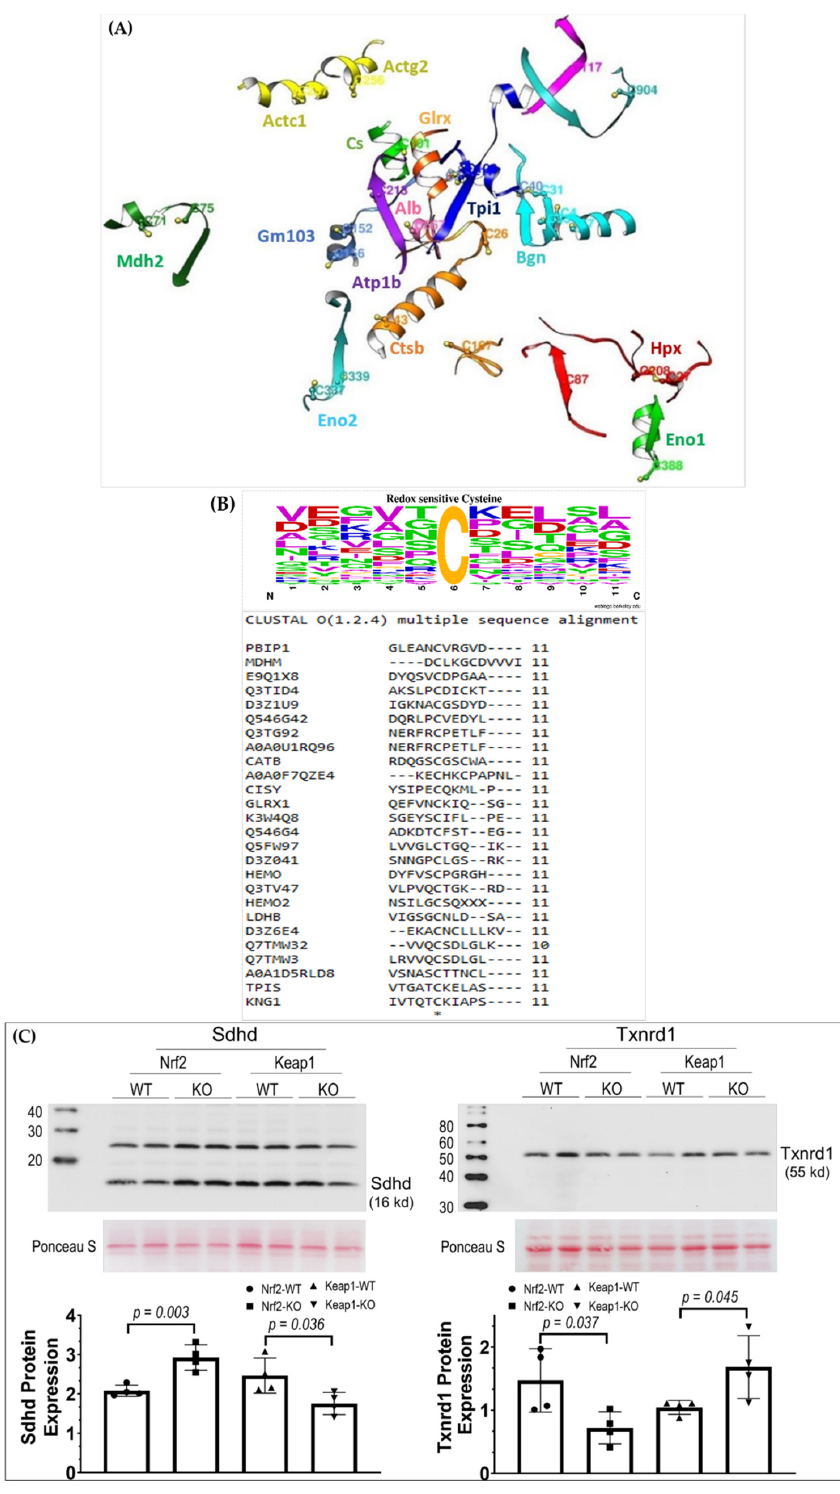
Figure 2. Structural comparison and sequence motif analysis of redox cysteine position in Nrf2 and Keap1 knockouts. ( A ) Superimposition of 3 ‐ D structure of peptides harboring redox cysteine (highlighted in ball and stick model). ( B ) Primary sequence motifs for modified cysteine residues. The central ‘‘C’’ represents the redox cysteine residue. The size of the letter represents the probability of the residue. ( C ) Western blot analysis of Sdhd (left panels) and Txnrd1 (right panels) of muscle in Nrf2 ‐ WT, Nrf2 ‐ KO, Keap1 ‐ WT, and Keap1 ‐ KO mouse models. Up panels: raw data of Western blots; Bottom panels: group data showing as mean ± SD; n = 4 for each group.